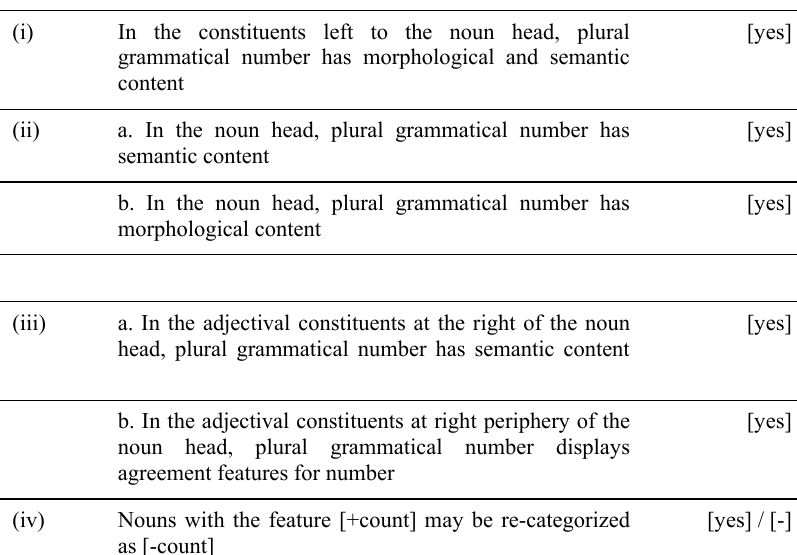
Table 9: Grammar parameters setting for defective